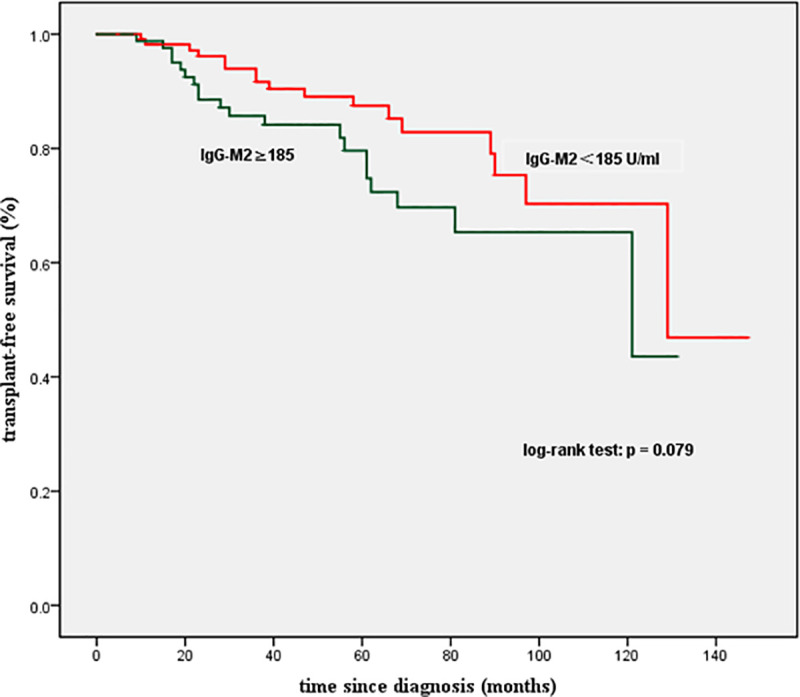
Kaplan–Meier plots for transplant-free survival among patients with PBC stratified by IgG-M2 levels.No significant difference was observed (P<0.05). IgG-M2, IgG antimitochondrial M2 antibody.